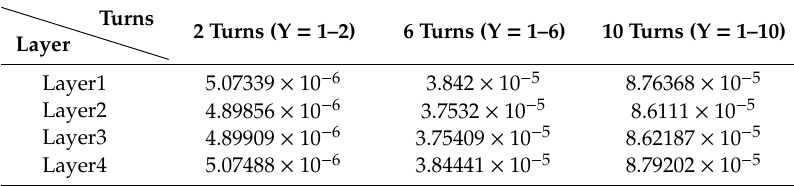
Table 2. The self-inductance of the faulty part in the finite element